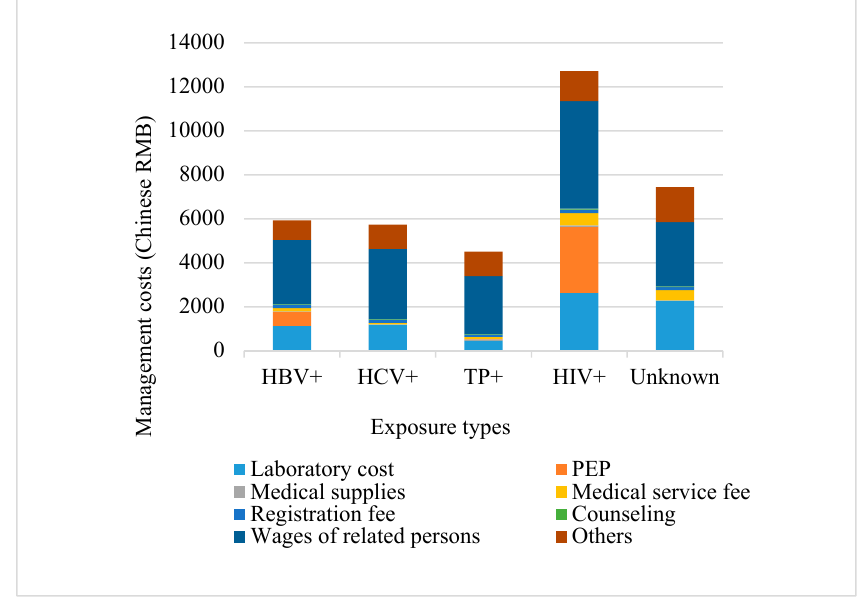
Figure 3. Direct and indirect costs categorized by the different types of medication. HIV: human immunodeficiency virus; HBV: hepatitis B virus; HCV: hepatitis C virus; TP: Treponema pallidum; PEP: post-exposure prophylaxis. Mean costs were weighted by the number of staff with invasive duties at each healthcare facility.